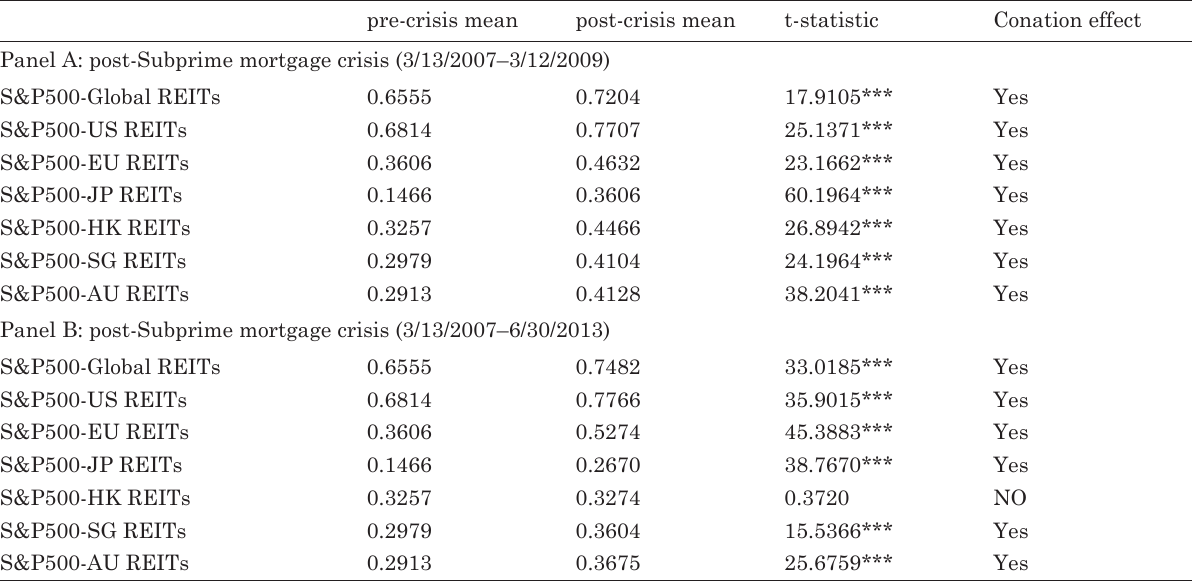
Table 5. Dynamic conditional correlation and contagion effect